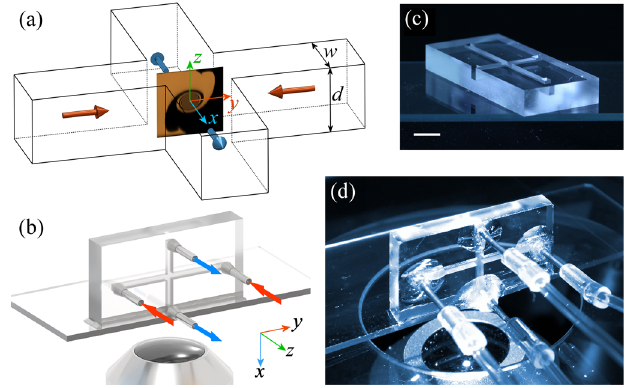
FIG. 1. The cross-slot geometry, where inflow is along the y direction (indicated by the red arrows) and outflow is along the x direction (indicated bythe bluearrows). (a) Schematic diagram of a cross-slot device showing the characteristic channel dimensions and the coordinate system, with origin at the geometric center of the crossing channels. A spiral vortex forms along the x axis for Re > Re . (b) A scheme illustrating a design for a microfluidic c cross-slot device allowing direct observation of the z - y plane at x ¼ 0 . The device is vertically mounted on an inverted microscope with a long working distance lens, enabling a direct view of the stagnation point region at the center of the geometry where the spiral vortex instability forms. (c) A prototype microfluidic cross- slot device for illustrative purposes (with channel dimensions w ¼ d ¼ 1 mm), fabricated in fused silica using selective laser- induced etching: scale bar 5 mm. (d) Photograph illustrating the experimental setup with the cross slot mounted on an inverted